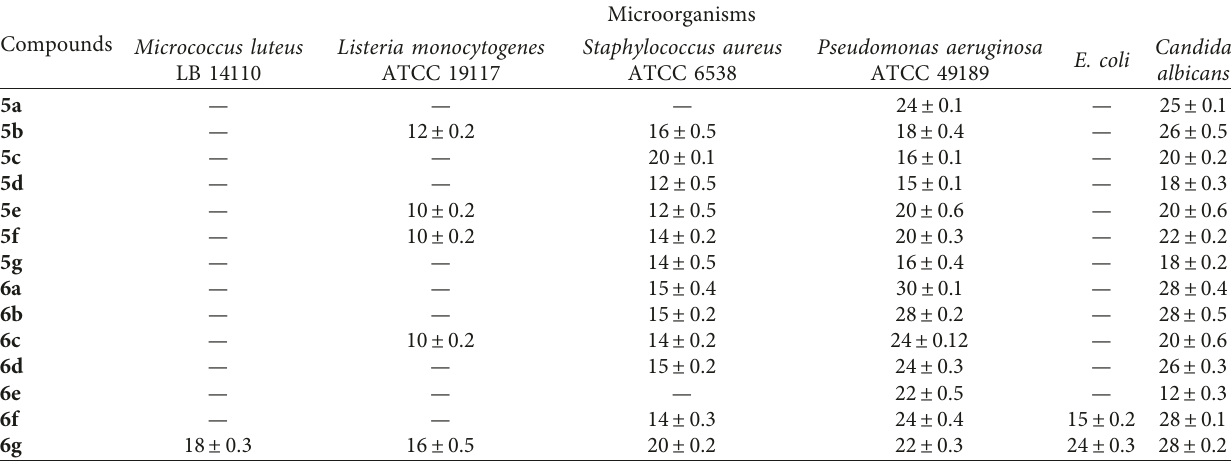
Table 4: Antibacterial activity of the prepared compounds 5 ( a – g )– 6 ( a – g ).